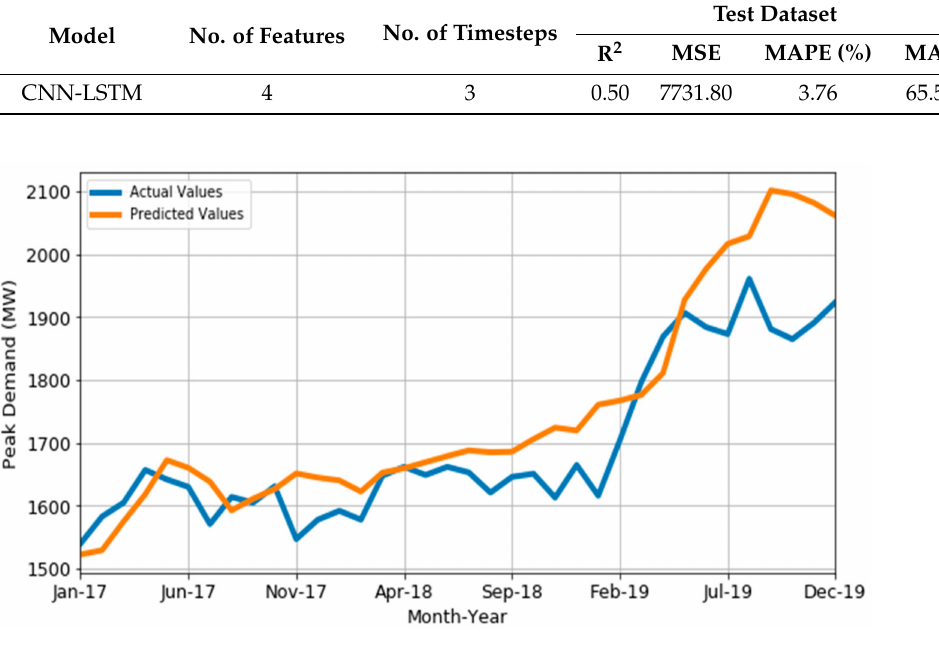
Figure 13. Performance of the multivariate CNN-LSTM model on the test